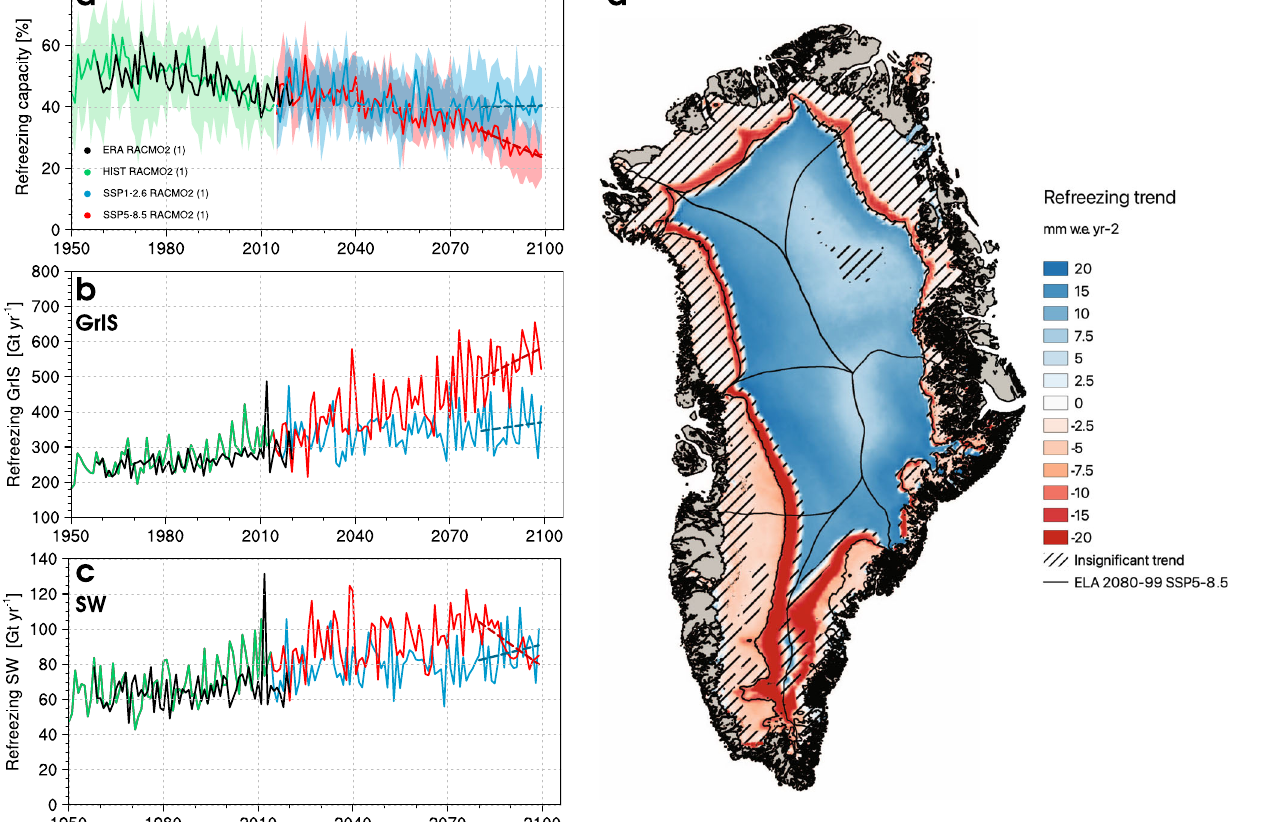
black line in a – c represents the reanalysis-forced RACMO2.3p2 simulation (1958 – 2020) 10 . d RefreezingtrendfromtheCESM2-forcedRACMO2.3p2projection under SSP5-8.5 over 2080 – 2099. Black contour represents the equilibrium line altitude (ELA) in 2080 – 2099 and hatching outlines insigni fi cant trends ( P > 0.05). Dashed coloured lines in a – c represent trends for the period 2080 –